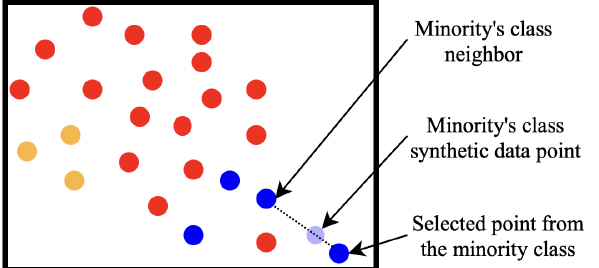
Figure 20. Toy example of the SMOTE algorithm for one iteration. The dataset has two minority classes (blue and orange) and one majority class (red). After selecting a minority class instance and its nearest neighbor, a synthetic data point is added somewhere in the line segment between